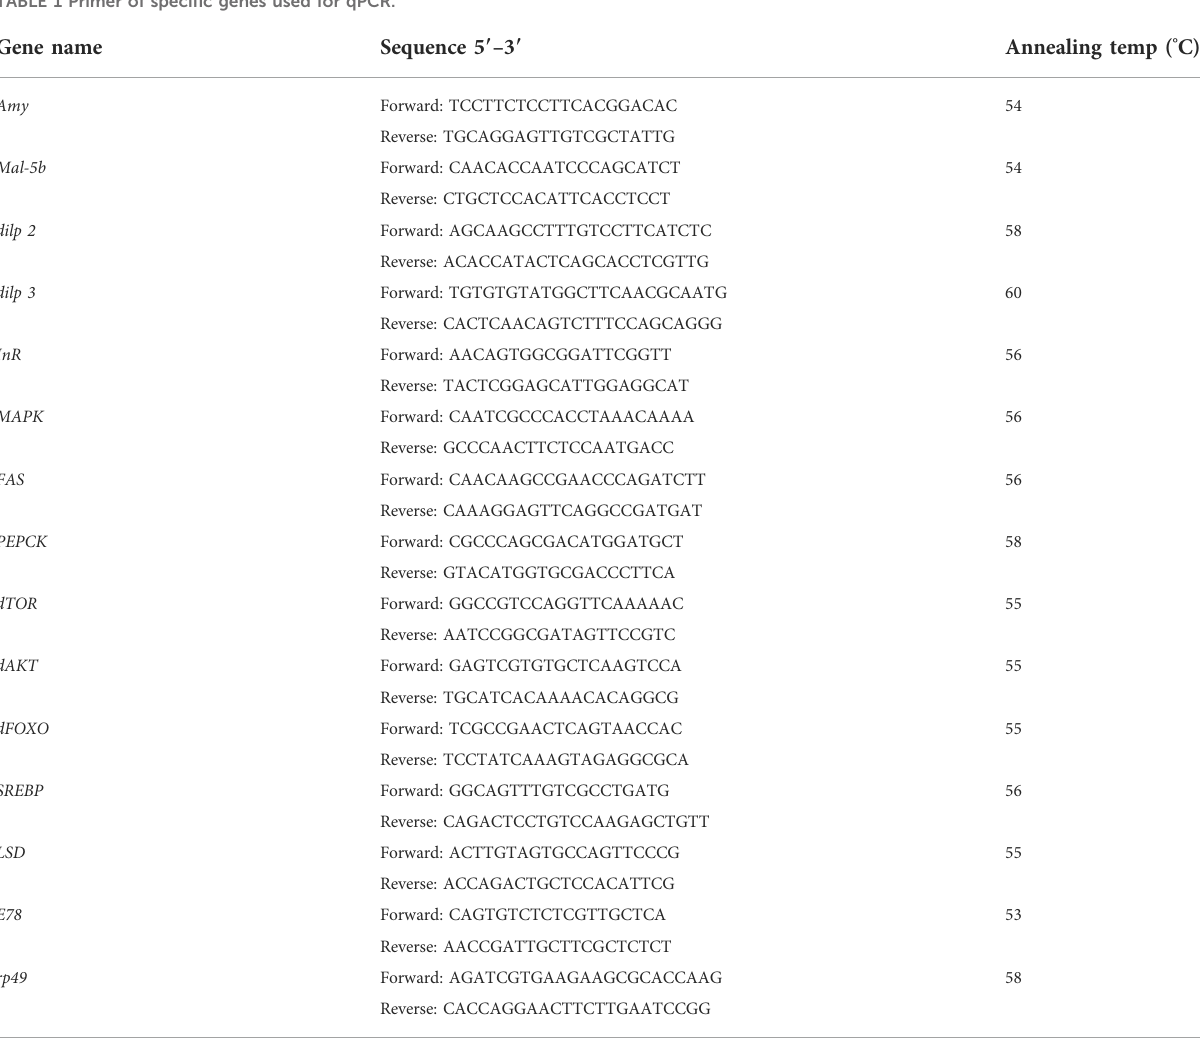
TABLE 1 Primer of speci fi c genes used for